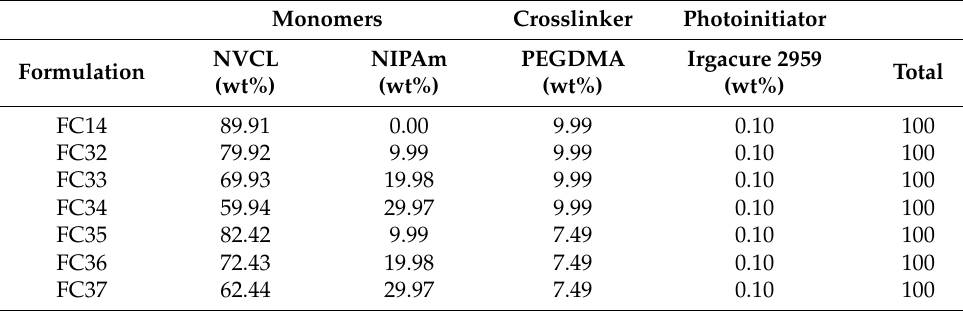
Table 4. Compositions of chemically crosslinked xerogels.